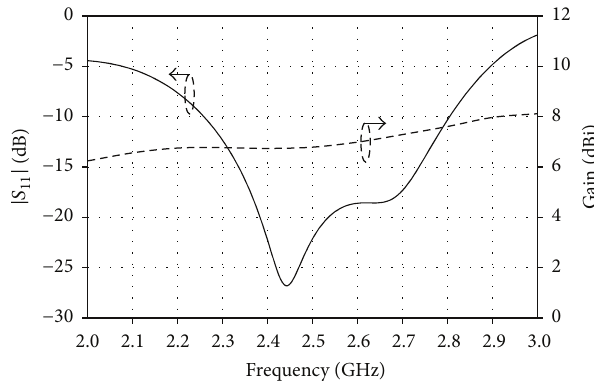
Figure 4: Simulated |𝑆 11 | and gains relative to frequency of the antenna without parasitic coupling apertures.